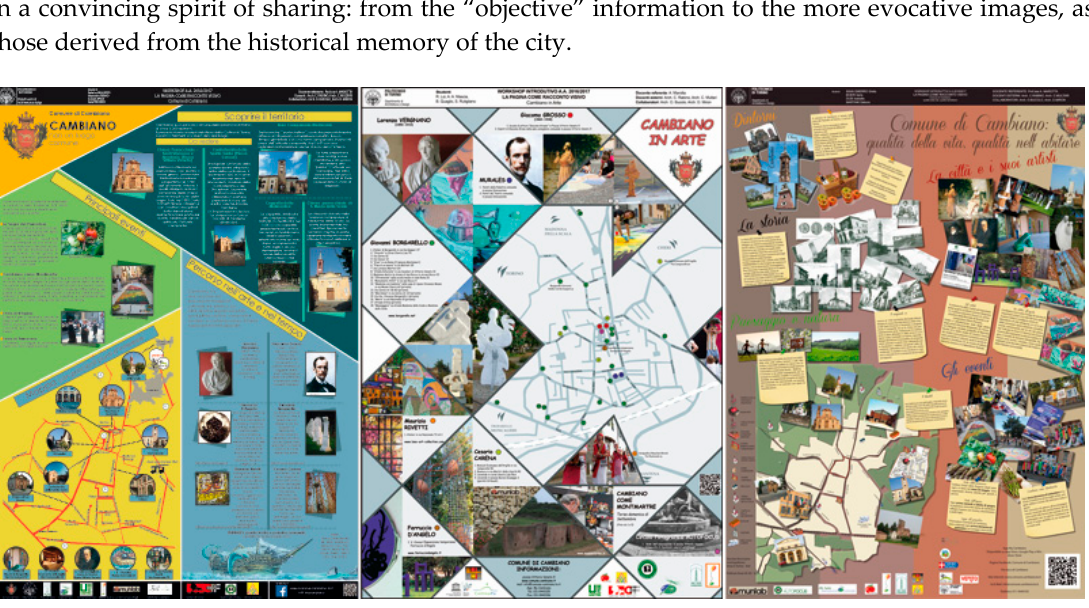
Figure 1. Three of the four promotioning panels of Cambiano’s cultural heritage. They show the places of greatest historical interest, the characterizing events of the country’s culture and the artistic works disseminated on the